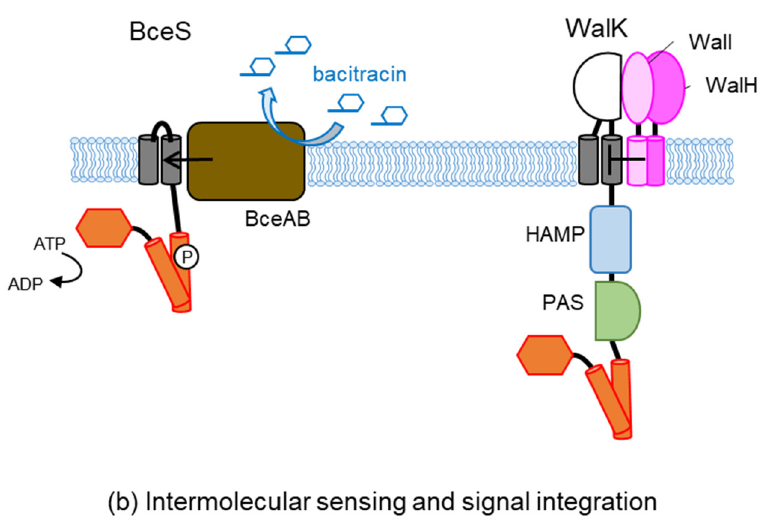
Figure 3. Signal perception in the TM domain. Modulating signals can be sensed either directly ( a ) or indirectly via other proteins ( b ). ( a ) DesK and MS-DesK (minimal sensor-DesK, which has only a single chimera TM helix of the N-terminal half of TM1 and the C-terminal half of TM5) sense low temperature by detecting the changes in membrane thickness, fluidity, and water permeability [86]. AgrC is modulated by the direct binding of a quorum-sensing factor, AIP (autoinducing peptide) [87]. ( b ) BceS forms a sensory complex with an ABC transporter, BceAB. The flux of peptide antibiotics such as bacitracin activates BceS [88]. Although WalK has both extracellular and intracellular signal domains, WalK activity is also modulated by two membrane proteins, WalH and WalI, through interaction at the TM domain. Whereas WalH and WalI repress WalK activity in Bacillus subtilis [89], these two proteins activate WalK in S. aureus [90,91]. HKs normally exist as dimers but are shown as monomers for simplification.